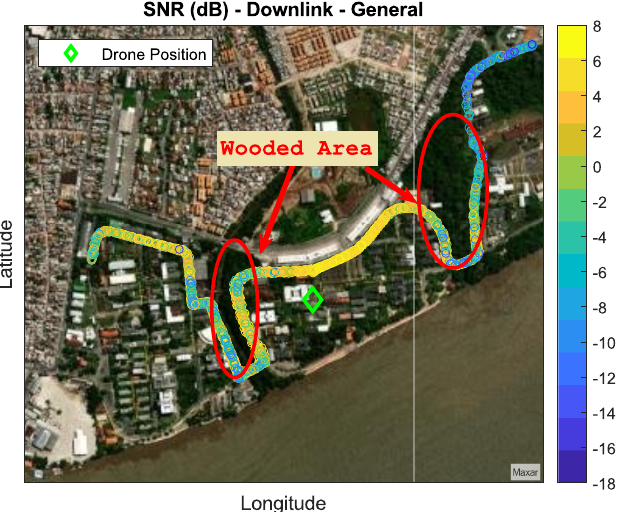
Figure 6. Downlink measured data.